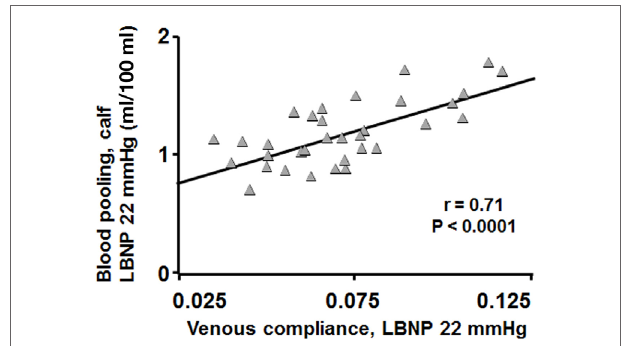
FigUre 1 | Blood pooling in DW and c during lBnP of 22 mmhg plotted against their calculated venous compliance at concomitant evoked transmural pressure (gray triangles) . Blood pooling correlated well with venous compliance ( r = 0.71, P <